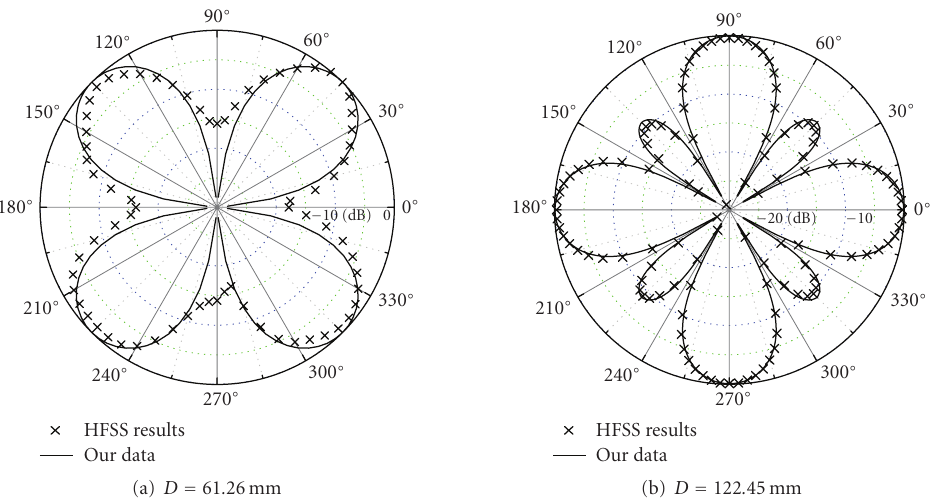
Figure 13: Comparison of our results with those obtained by HFSS for a four-monopole antenna’s H-plane radiation pattern ( f = 2 . 45GHz, V 1 = V 2 = V 3 = V 4 = 1V, θ = 90 ◦ ).